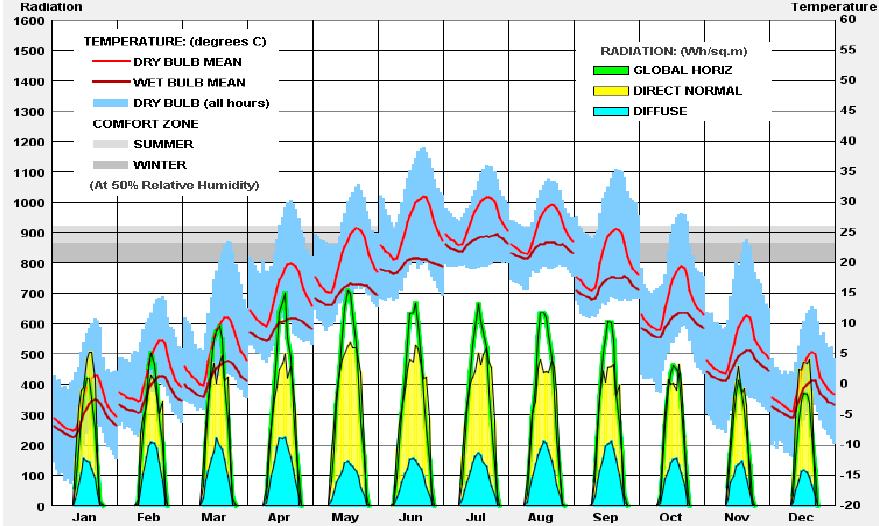
Figure 2. Hourly Meteorological Data of Typical Meteorological Years in Baoding Area.